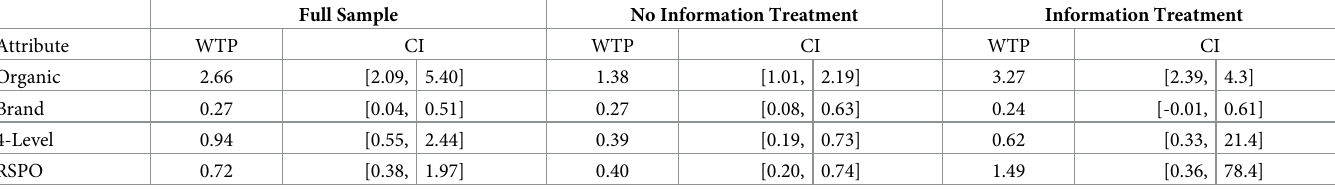
Table 6. Average willingness-to-pay